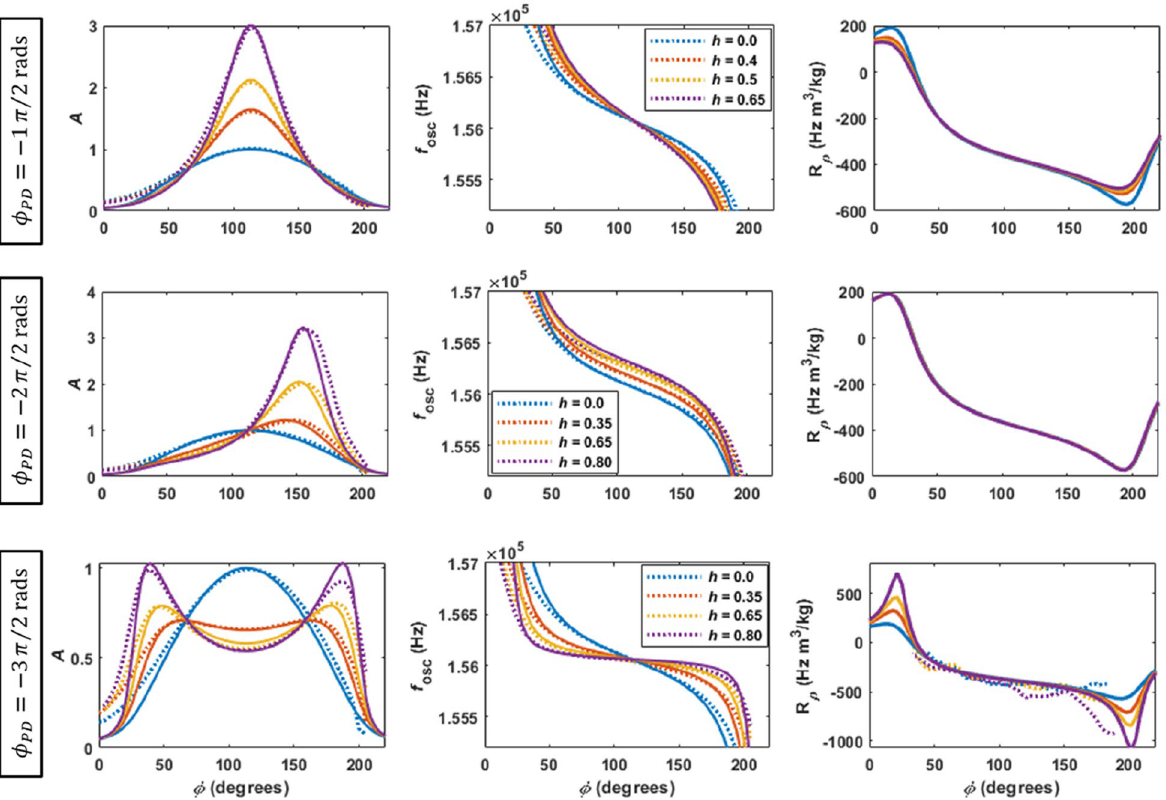
Figure 2. Modelled (solid lines) and experimental (dotted lines) amplitude and frequency of oscillation, and responsivities to density variations (3%), as function of the imposed phase ( φ ) in the PLL and the parametric pump gain ( h ) and phase ( φ PD ), for the closed cell filled with air. A constant transduction gain of 1/1100 is used to fit the experimental values of amplitude of oscillation to the modelled